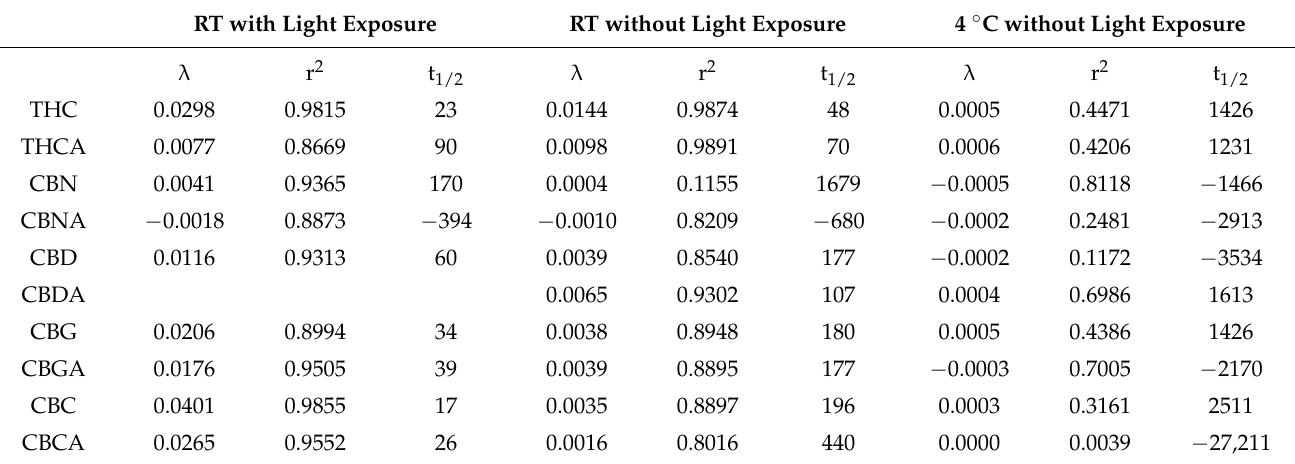
Table 2. Degradation rate constants ( λ ) of cannabinoids at different